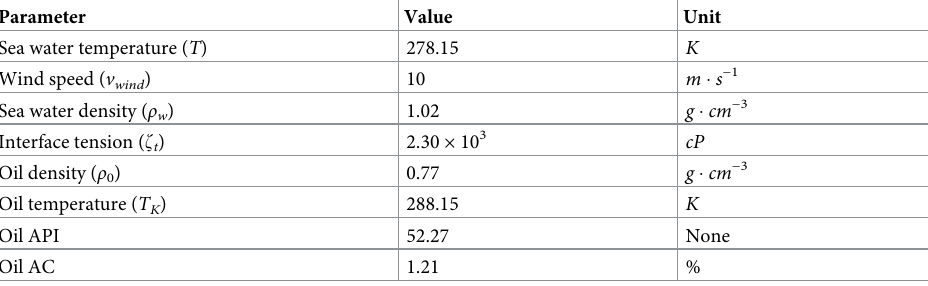
Table 6. Parameters for the simulation of weathering processes.